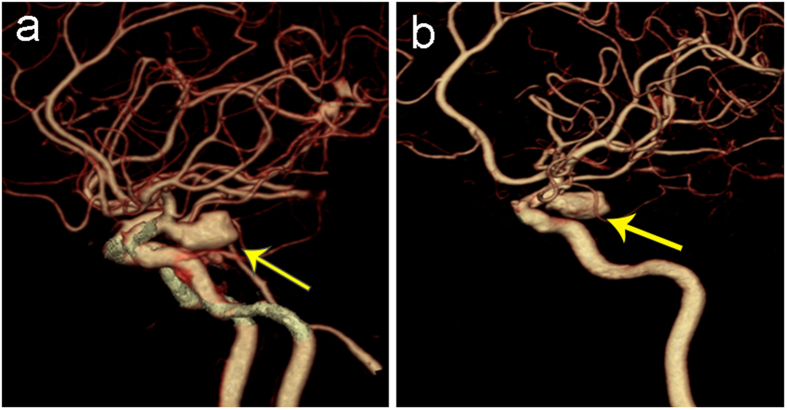
A 55-year-old women with a giant aneurysm in left posterior communicating artery.(a) Volume-rendered dual-energy CTA image shows a true-positive aneurysm (arrow) in the posterior communicating artery, which was confirmed by 3D-DSA (b).